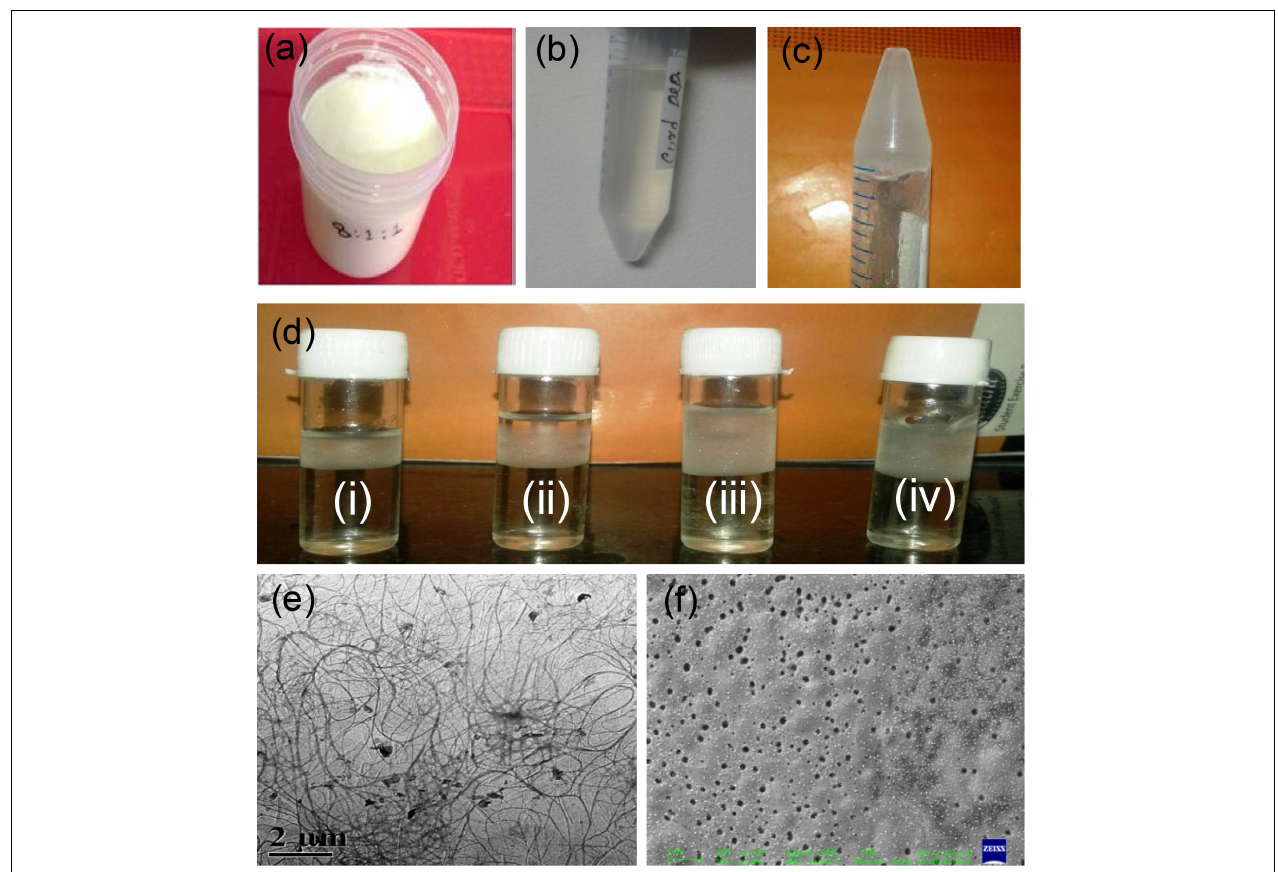
FIGURE 1 | Hydrogel preparation from extracted curd peptides. Prepared curd in the laboratory (a) ; extracted curd peptide pool (b) ; hydrogel from peptide (c) ; optimization of